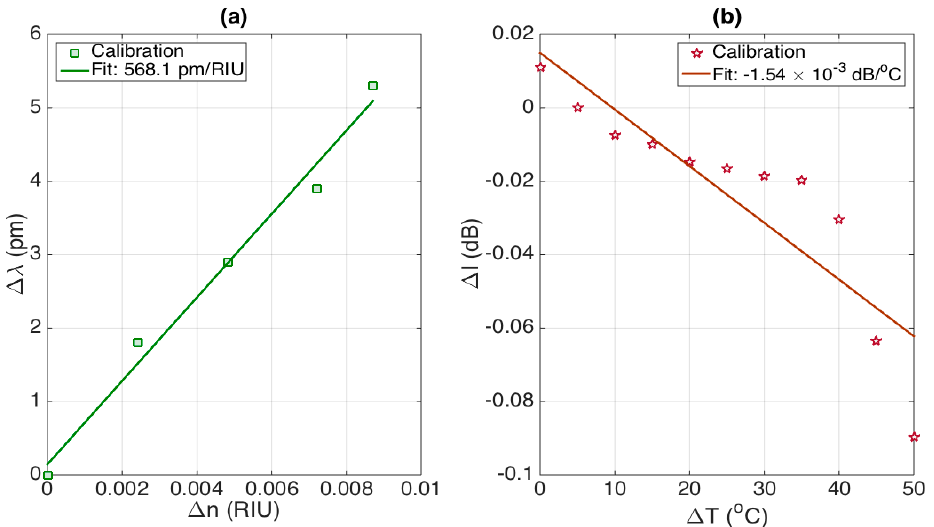
Figure 8. Evaluation of the cross-sensitivities of the stCFBG sensitivity to RI and temperature. ( a ) Effect of the RI change on the wavelength shift estimation, evaluated as 568.1 pm/RIU; ( b ) effect of the temperature change on the intensity level of the post-taper bandwidth, estimated as − 1.54 × 10 − 3 dB/°C.